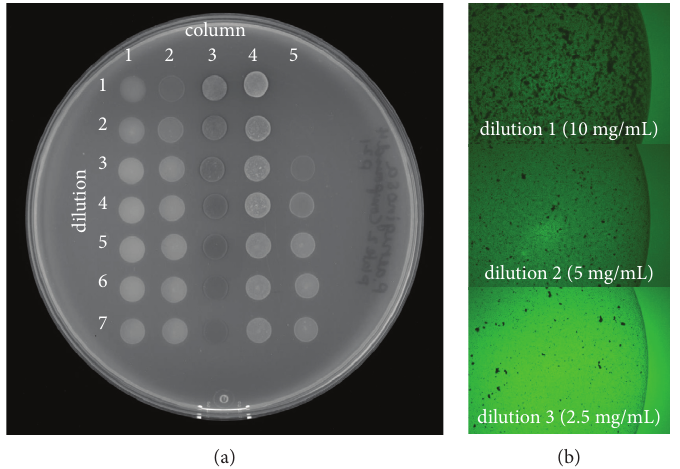
Figure 2: A representative bacterial growth spot assay on a tryptic soy agar culture plate imaged with epi illumination at 365 nm. 5 μ L of mixtures were spotted down columns 1, 2, 4, and 5 with the highest concentration at dilution 1 and the lowest concentration at dilution 7. (a) Column 1 was P . aeruginosa with TB (TB+); column 2 was P . aeruginosa with DMSO (DMSO+); column 3 was dissolved UV compound in DMSO without bacteria (UV compound+DMSO − ); column 4 was P . aeruginosa with UV compound in DMSO (UV com- pound +DMSO+); and column 5 was P . aeruginosa with kanamycin antibiotic (kanamycin+). (b) Representative microscopic imaging of UV filter residue physically occupying tryptic soy agar